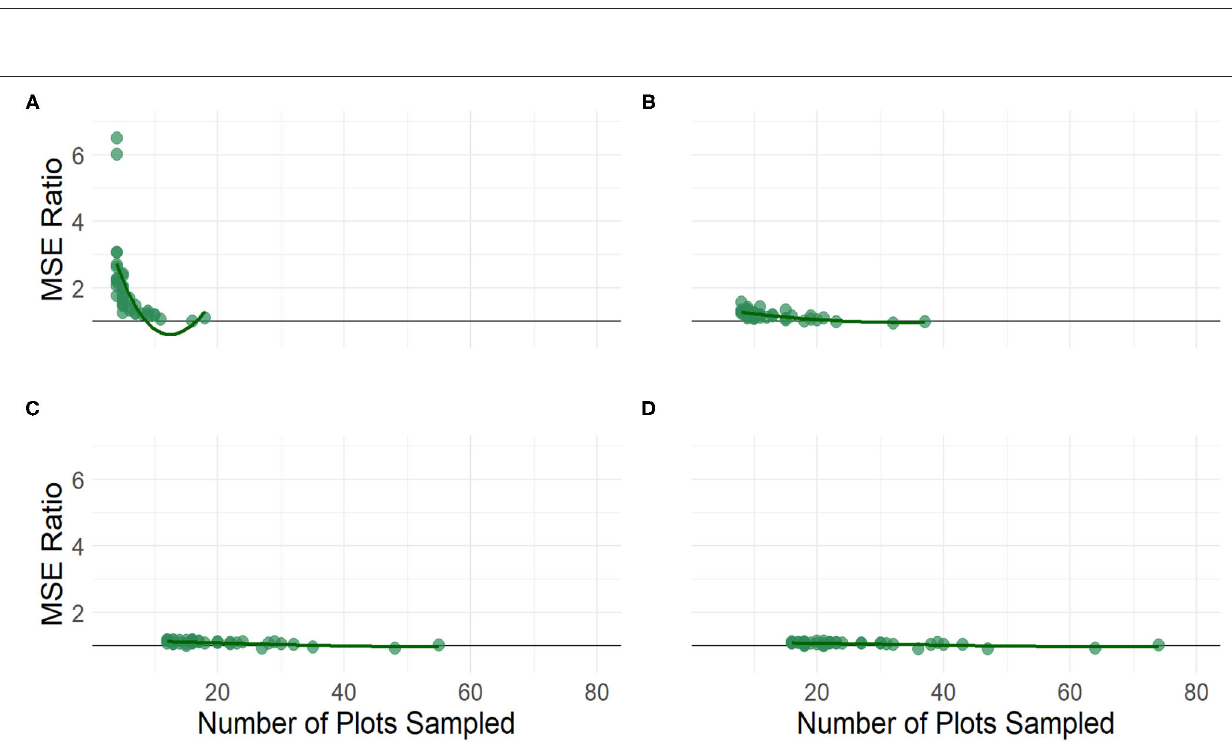
Frontiers in Forests and Global Change |